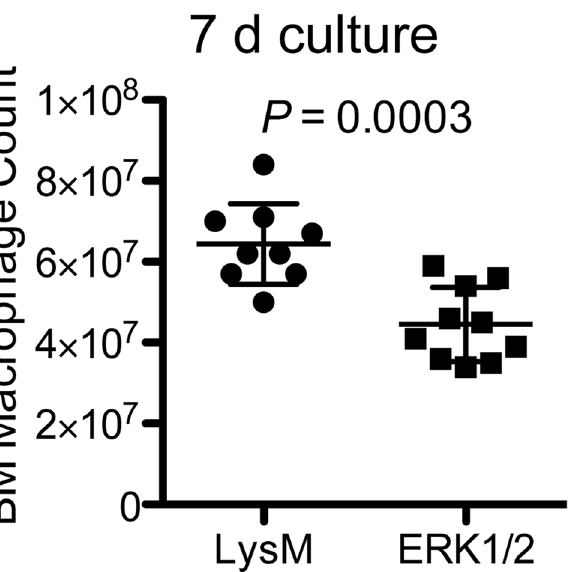
Fig 3. Macrophage yield from M-CSF-stimulated bone marrow cultures is reduced in ERK1/2 mice. 2.5×10 7 bone marrow cells from ten individual mice of each genotype (LysM and ERK1/2) were cultured for 7 d in 50 ml D10F with 25% LADMAC cell conditioned medium, and macrophage yields were determined by cell count with Trypan Blue exclusion.